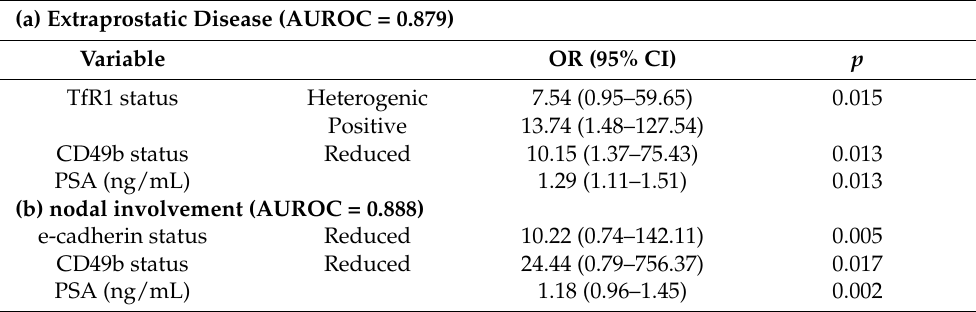
Table 4. Multivariate analysis for prediction of extraprostatic disease (a), and nodal involvement